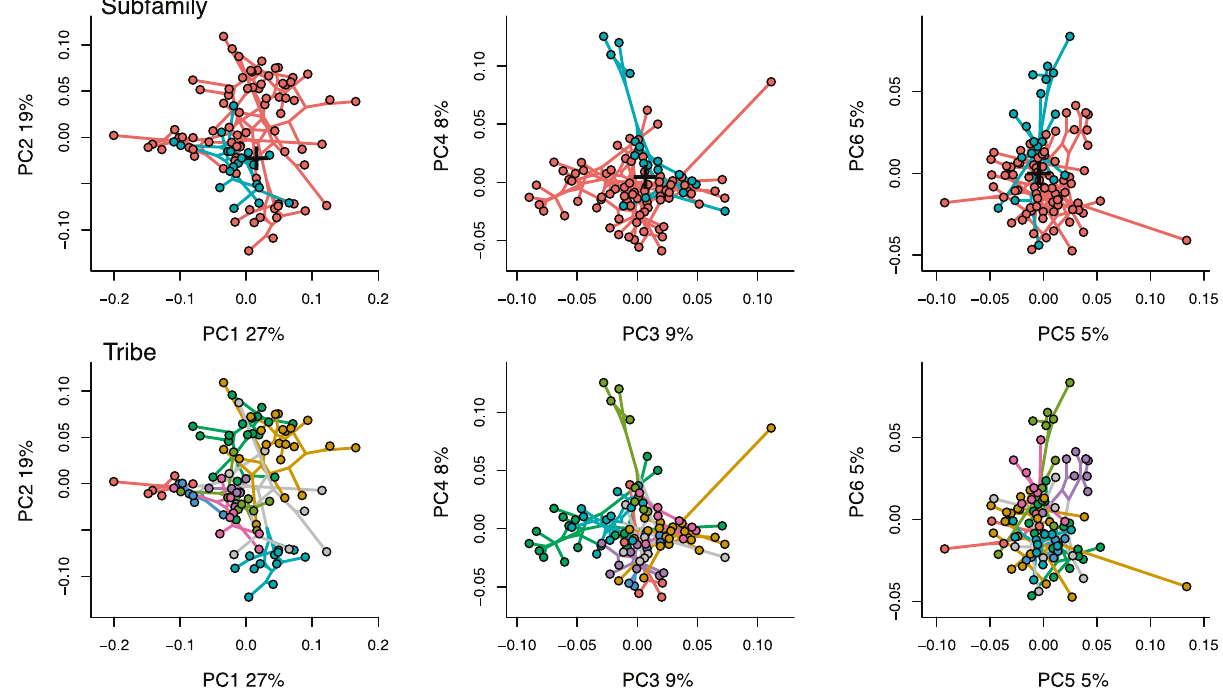
Fig. 3 Phylomorphospace along the fi rst six principal components. Whether examined by subfamily or tribe, bovid cranial morphospace shows high overlap and poor phylogenetic differentiation. The black + marks the reconstructed position of the most recent common ancestor of all extant bovids (root node in Fig. 1). The correspondence between colors and clades is the same as in Fig. 1. Table 1 Relationship of cranial shape and log-centroid size to the most important variables examined in this study (individual ANOVAs using residual randomization).